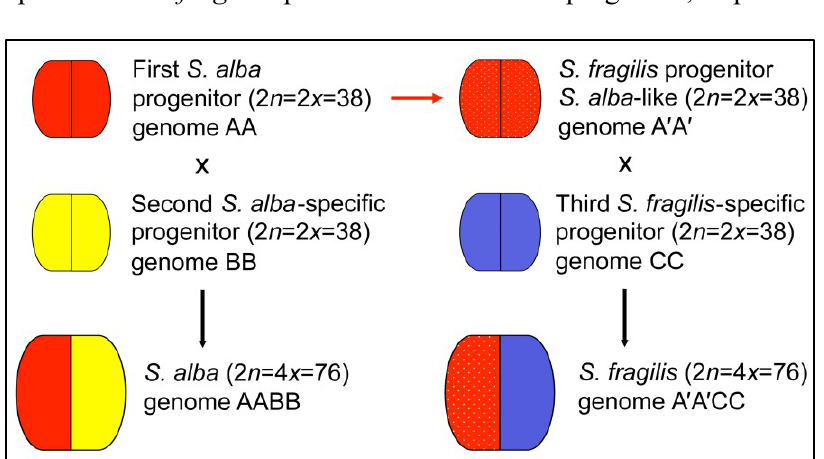
Figure 3. Working hypothesis relating to the genomic organization of S. alba and S. fragilis genomes, along with their origin and relationship with putative diploid ancestor species. Letters A and A′ refer to the shared or closely related diploid progenitor species of S. alba and S. fragilis whose genome(s) contributed with contracted chromosomes ( i . e ., first common ancestor), whereas letters B and C indicate the two additional and different progenitor’ genomes which transmitted the extended chromosomes to both S. alba and S. fragilis species ( i . e ., S. alba -specific and S. fragilis -specific second and third progenitor,